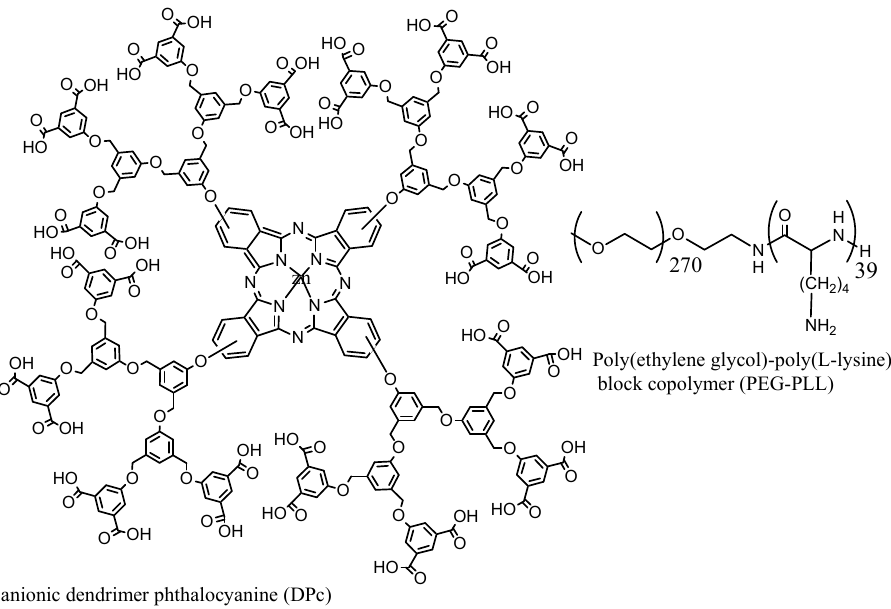
Figure 14. A dendrimer-based phthalocyanine structure for sensitizer